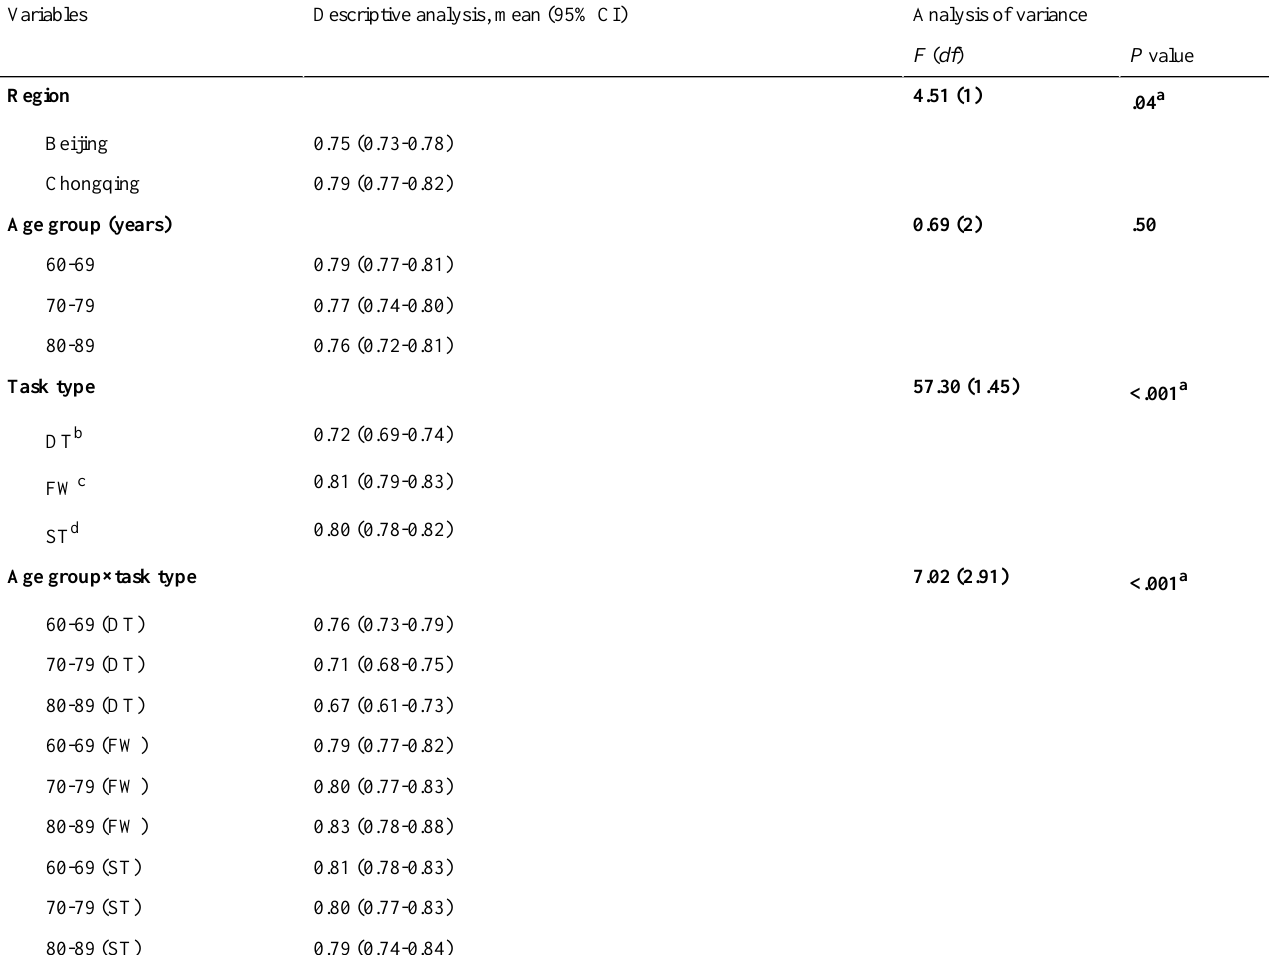
Table 5. Statistics for step regularity.